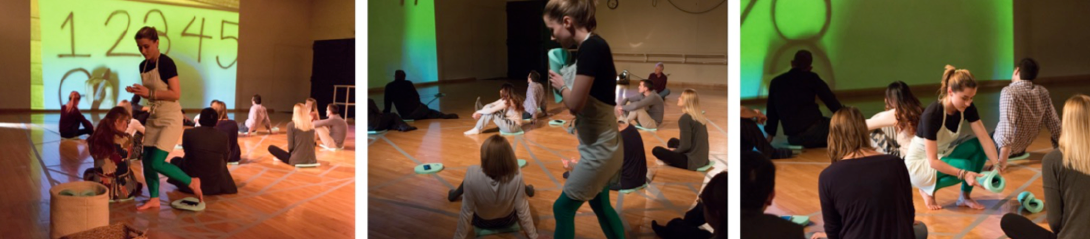
Figure 2. The performer ceremoniously laying out each audience member’s cell phone into the segmented space during reading of Turing’s excerpts. Photos by Natalie